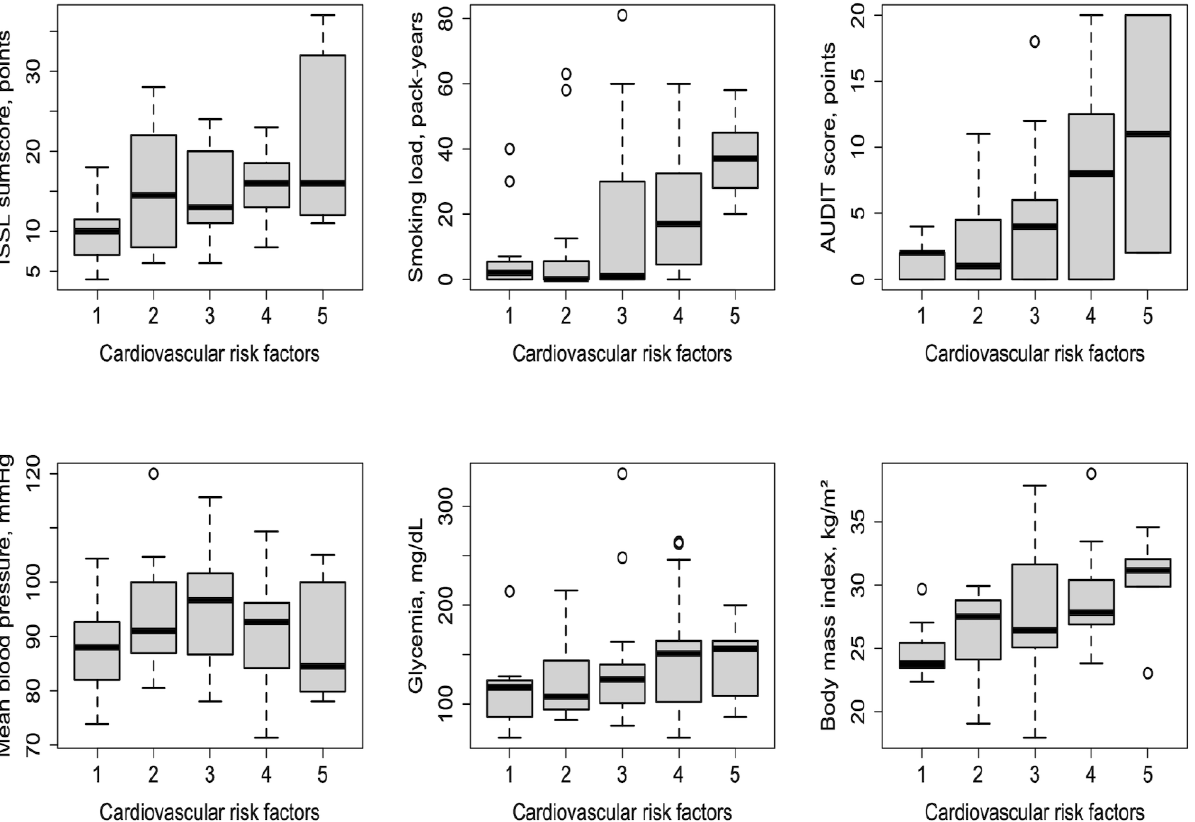
Figure 1. Boxplots of independent surrogate measures of cardiovascular disease risk factors (ISSL sumscore, smoking load, AUDIT score, mean blood pressure, glycemia, body mass index) across the combination of risk factors (stress, smoking habits, alcohol drinking, hypertension, diabetes mellitus, obesity). The horizontal axis represents the total number of cardiovascular risk factors (1–5) identified per participant based on the clinical and/or laboratory assessment. Notice no patient presented with all six cardiovascular risk factors simultaneously. Circles represent outliers. Table 2. Generalized linear models comparing the adjusted effect size of each cardiovascular risk factor (independent variables) on the total number of risk factors (dependent variable) after adjust- ment by age and sex.